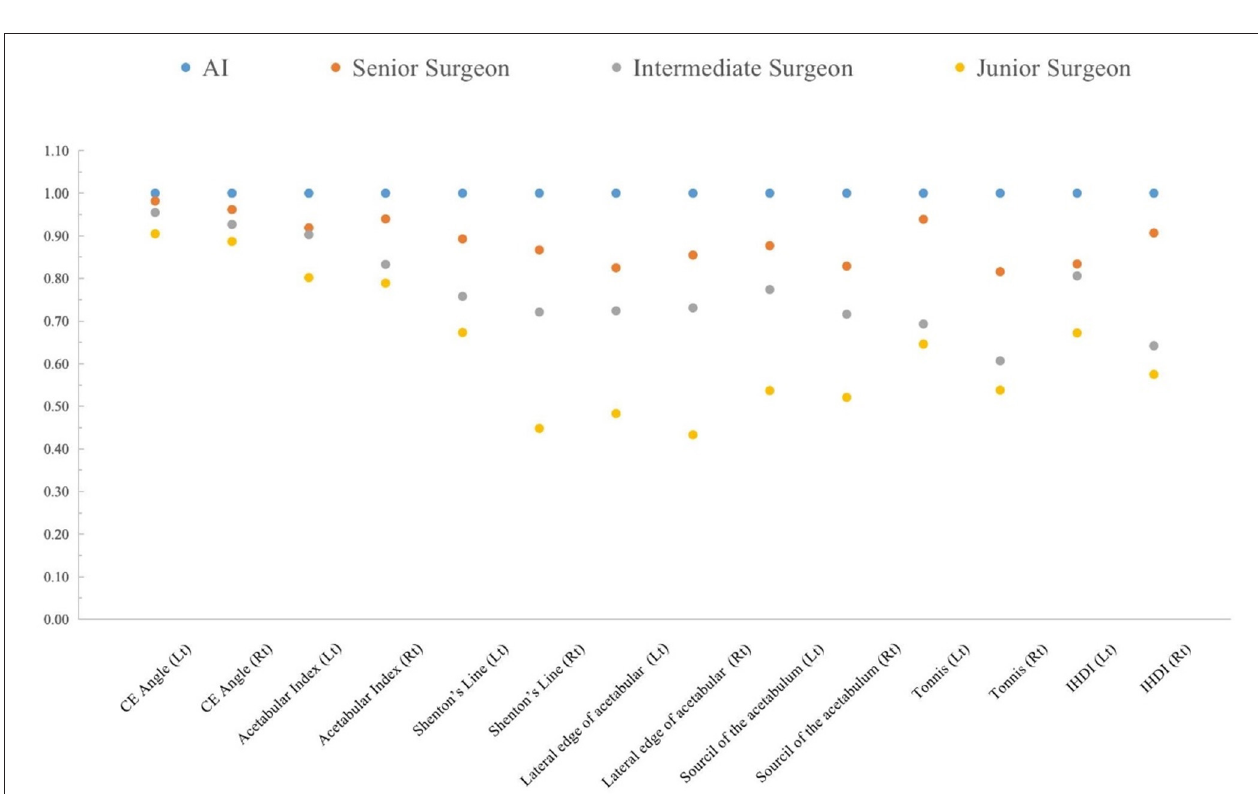
FIGURE 5 | The intraclass consistency test of 14 indicators in the AI system, senior surgeon, intermediate surgeon, and junior surgeon.